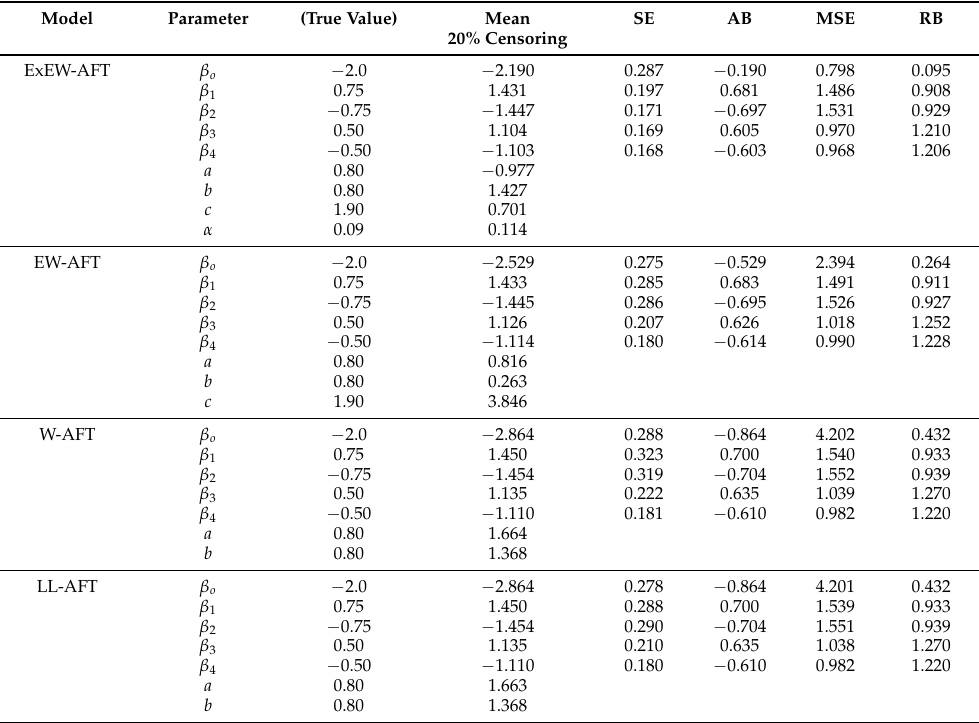
Table 5. Simulation study for scenario 2 ( n = 1000) with about 20% censored observations is used to compare model performance.